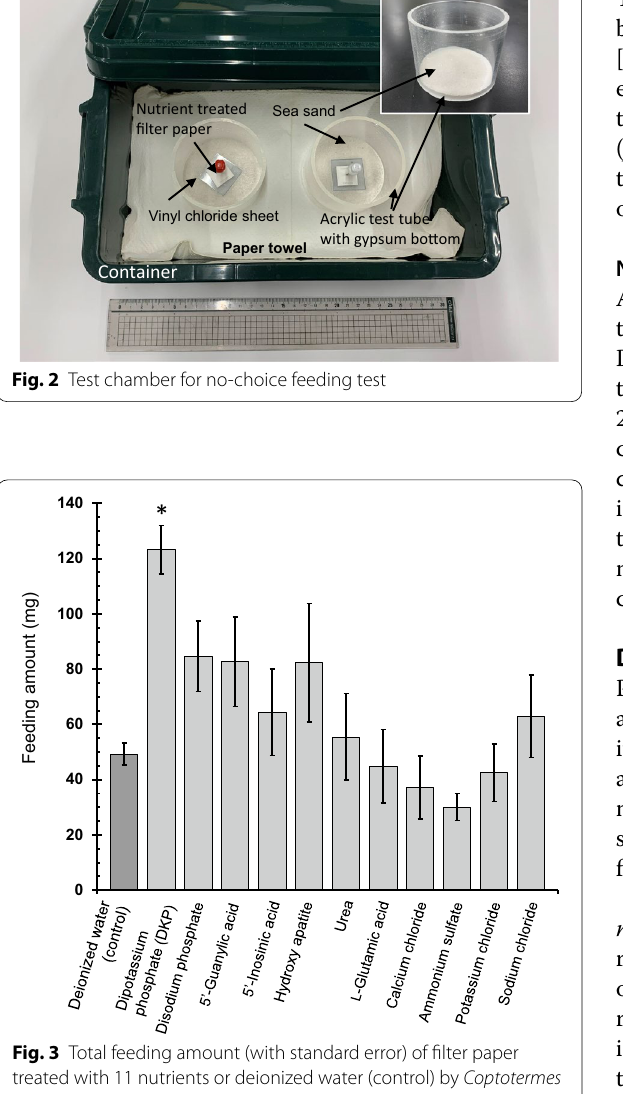
Table 2 Feeding amount, mortality, and termite body weight fluctuation rate of no-choice feeding test Treatment Control